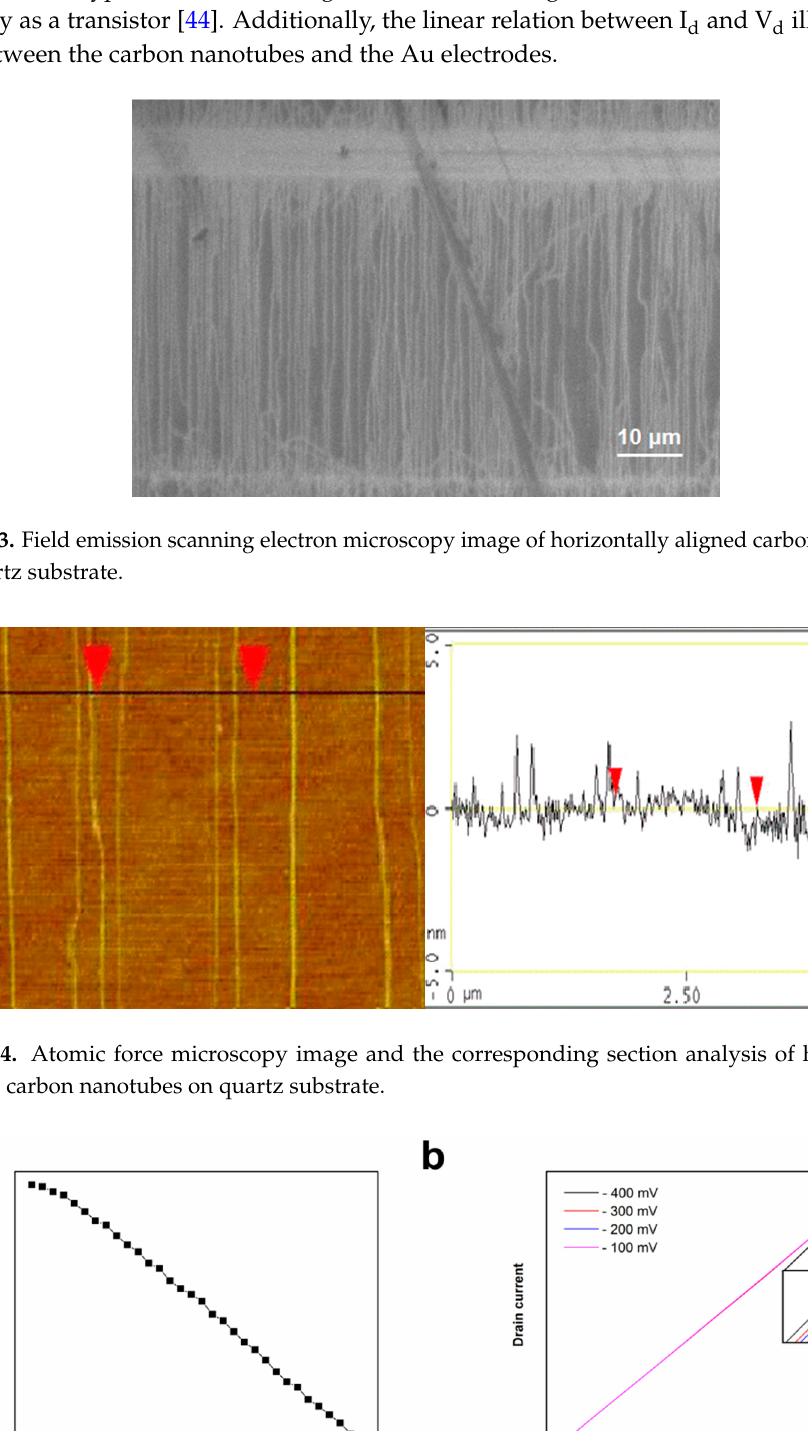
Figure 5. Atomic force microscopy image and the corresponding section analysis of horizontally aligned carbon nanotubes on quartz substrate. Before kinetic measurements, antibody-immobilized devices were incubated with PBS and the drain current (I d ) was allowed to stabilize so that the effects of non-specific binding of contaminants